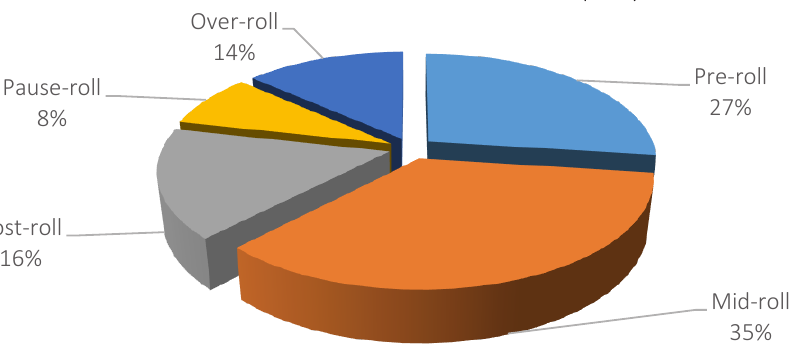
Figure 2. Level of annotations completion for all types of video advertising